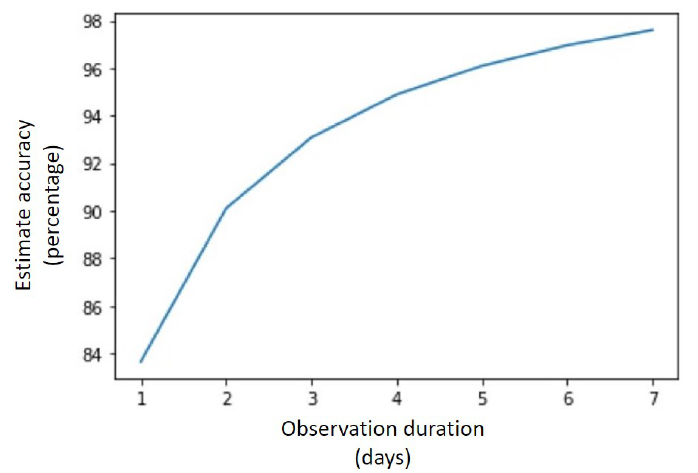
Figure 3. Estimate accuracy in relation to observation